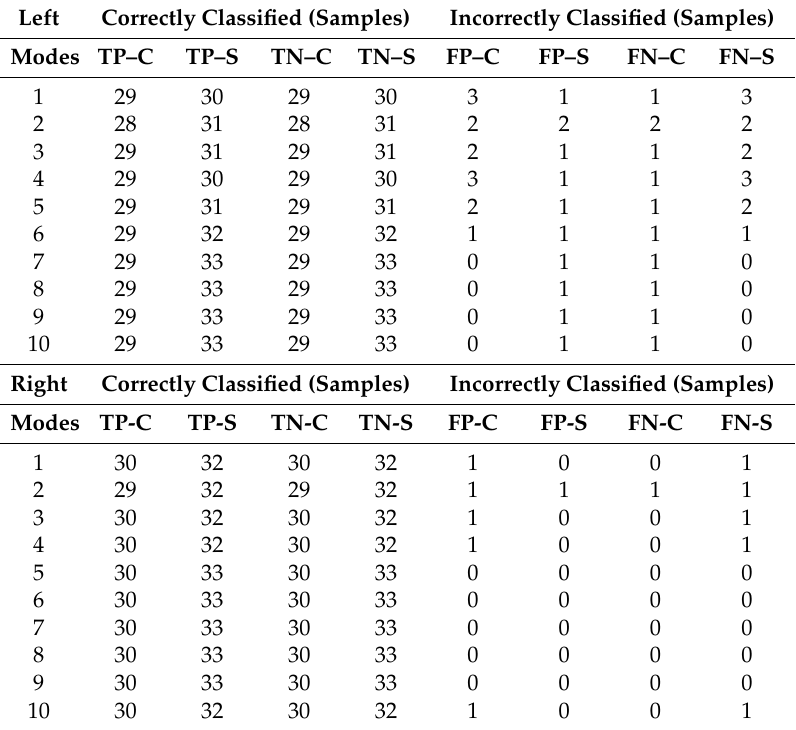
Table 3. Numbers of correctly (TP–C, TP–S, TN–C and TN–S) and incorrectly (FP–C, FP–S, FN–C and FN–S) classified hippocampal samples w.r.t. number of model parameters (modes) taken into account.